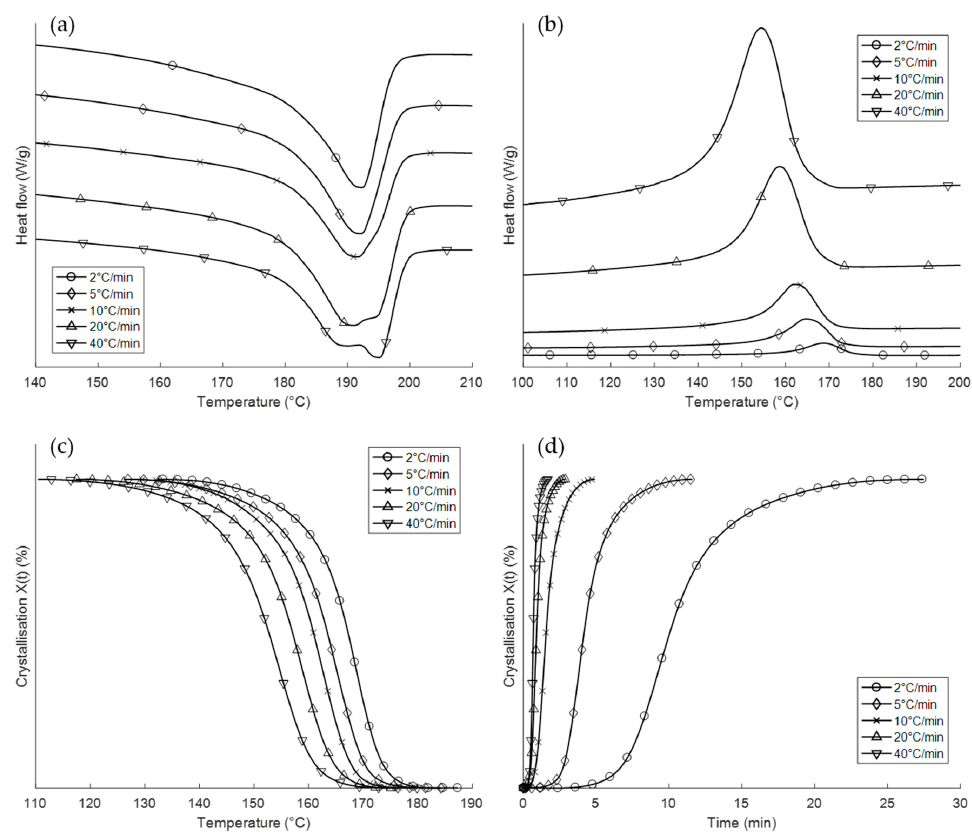
Figure 2. Results of the non-isothermal crystallisation experiments. ( a ) Heating endotherms for the second heating cycle. ( b ) Cooling exotherms during crystallisation. ( c ) Percentage of crystallinity X ( t ) as a function of temperature. ( d ) Percentage of crystallinity X ( t ) as a function of time. Table 2. The kinetic parameters for the non-isothermal crystallisation of Nylon-12.